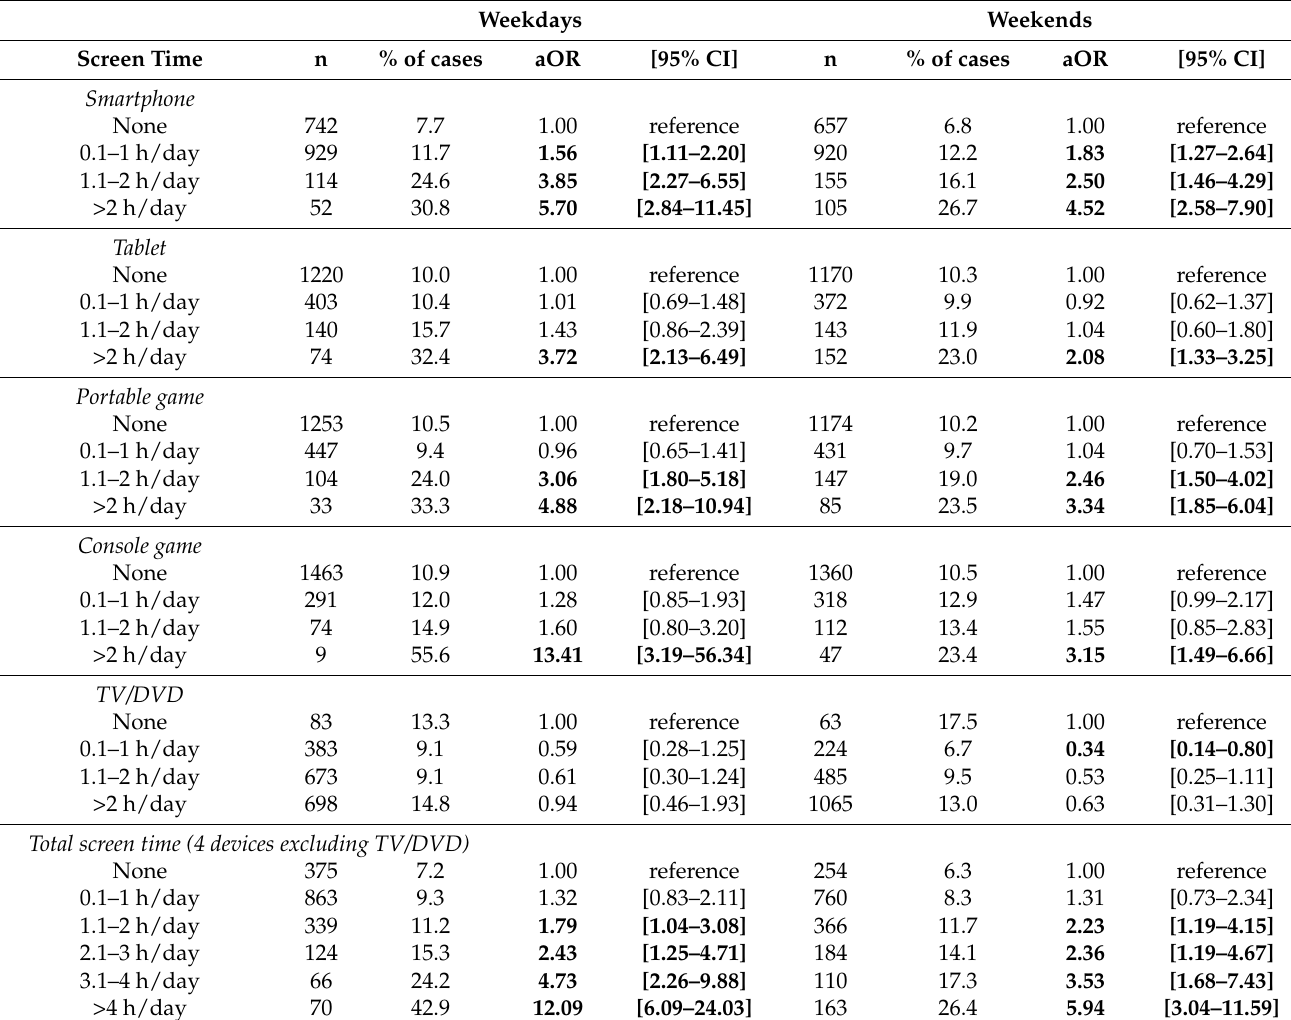
Table 4. Associations between children’s delayed bedtime (after 22:00 h) and screen time on weekdays and weekends (N =